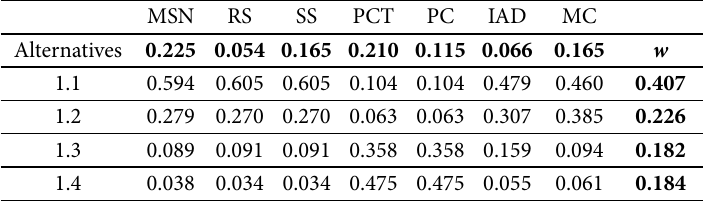
Table 17. The evaluation results for alternatives